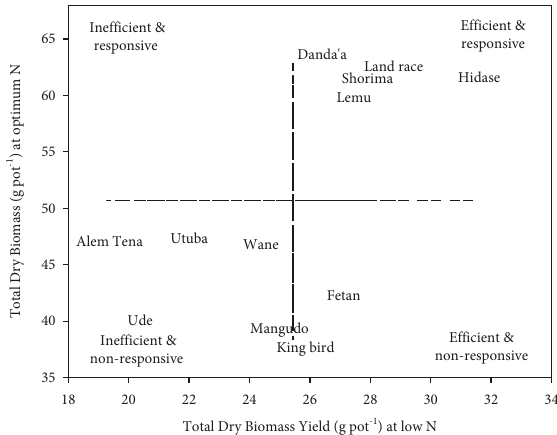
Figure 4: Categorization of wheat cultivars to N efficiency and N responsive using total dry biomass yield. Vertical and horizontal broken lines show average TBY under low and optimum N,